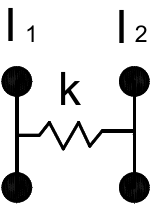
Figure 5. Two-degree-of-freedom simplification of a mechanical system.